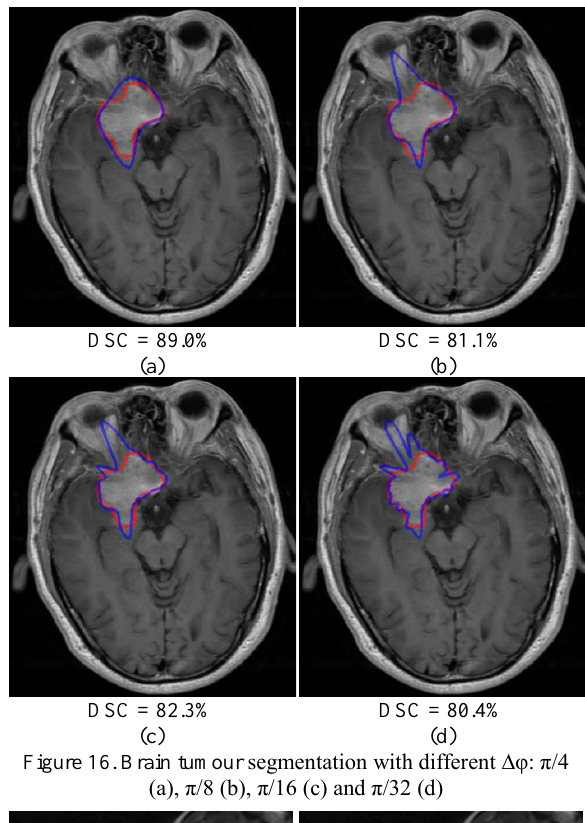
Figure 16. Brain tumour segmentation with different ∆φ: π/4